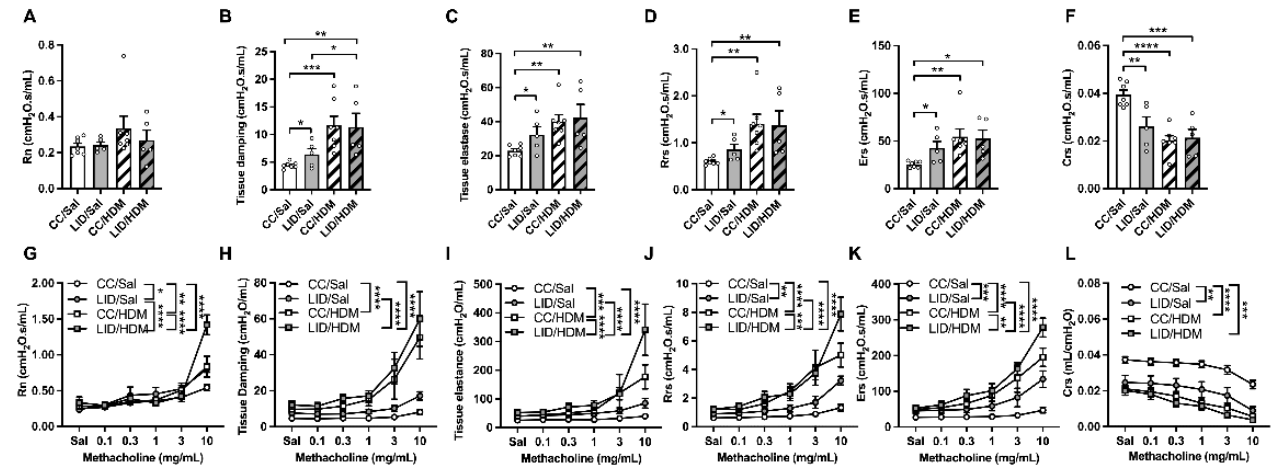
Figure 4. Low iron diet (LID) during pregnancy impairs lung function and increases AHR in female offspring in the absence and presence of HDM. Baseline lung function was assessed in terms of ( A ) central airway resistance (Rn), ( B ) tissue damping, ( C ) tissue elastance, ( D ) transpulmonary resistance (Rrs), ( E ) elastance (Ers), ( F ) compliance (Crs). Response to methacholine provocation was assessed in terms of ( G ) Rn, ( H ) tissue damping, ( I ) tissue elastance, ( J ) Rrs, ( K ) Ers, ( L ) Crs. ( A – F ) Analysed by one-way ANOVA with Fishers LSD and unpaired student t -test, ( G – L ) analysed by 2-way ANOVA and statistics at maximal dose from AHR curves presented. n = 5–7 mice per group. Data are presented as mean ± SEM (* p < 0.05; ** p < 0.01; *** p < 0.001; **** p < 0.0001).